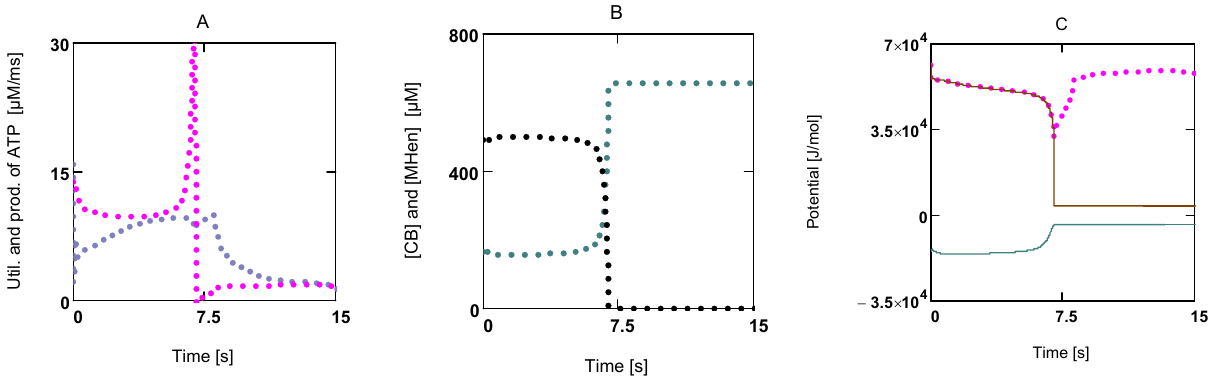
], and potentials of the cross- Figure 7. Time courses of and , of [CB] and [MH En bridge cycle during fatigue development. ( A) (red) ; (blue) ; ( B) (black) [CB]; (blue) [MH ]; ( C) (red points) A ; (brown line) ; (blue line) ; notice that after En ATP 7.5 s and become opposite and